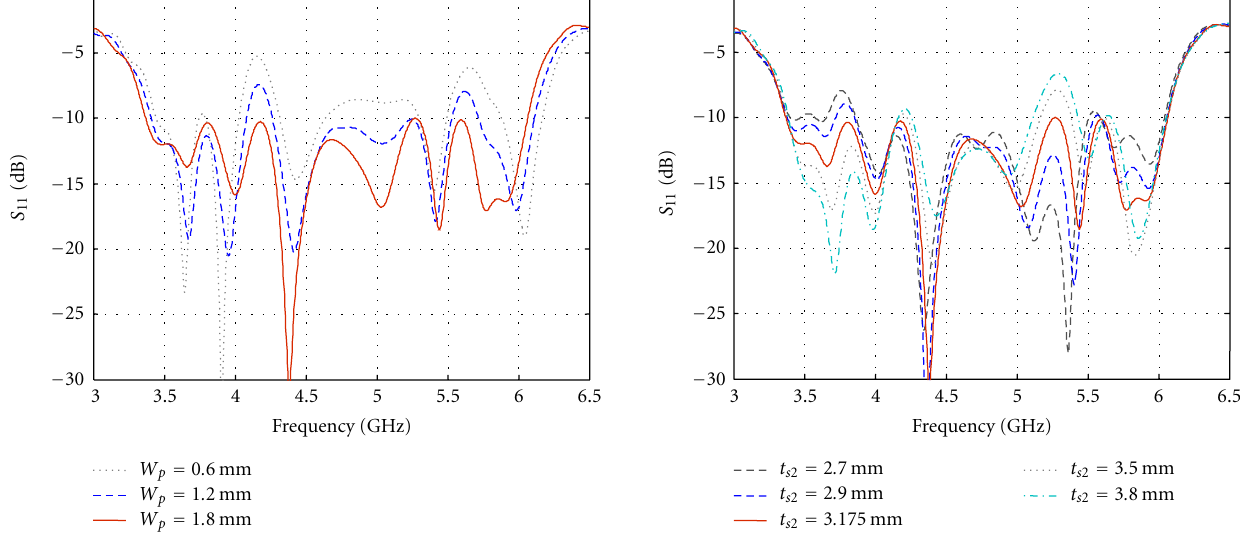
Figure 4: Reflection coe ffi cient of the MSA-BP for di ff erent thicknesses t .